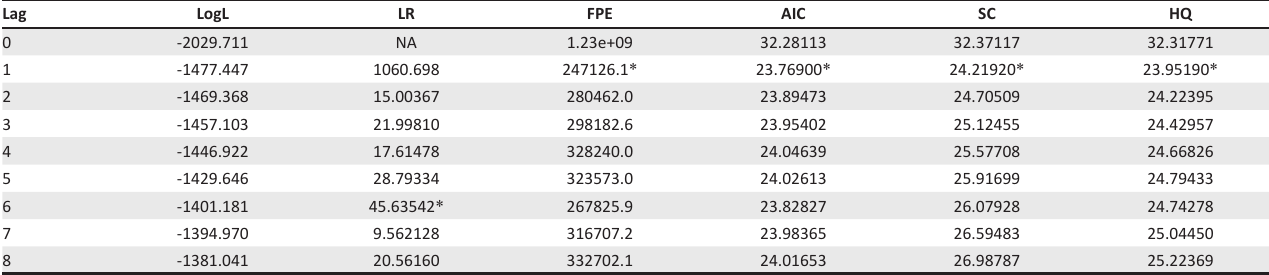
TABLE 2: VAR Lag order selection criteria,